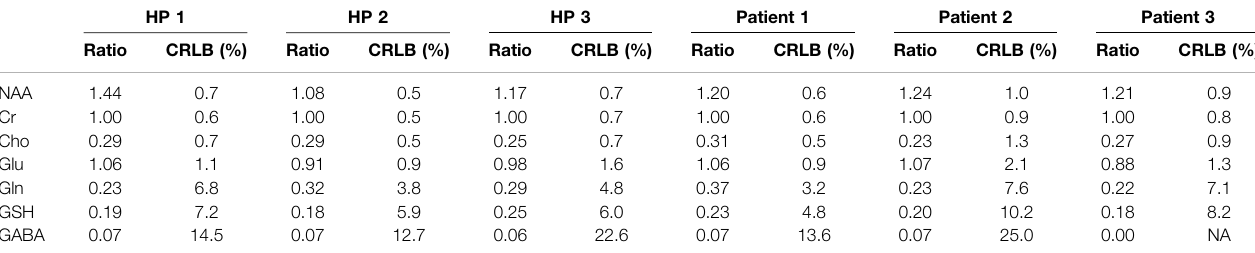
TABLE 1 | Metabolite ratios [/(Cr)] measured from the pACC of three healthy participants (HPs) and three MDD patients with TE = 106 ms and TE 1 = 16 ms.